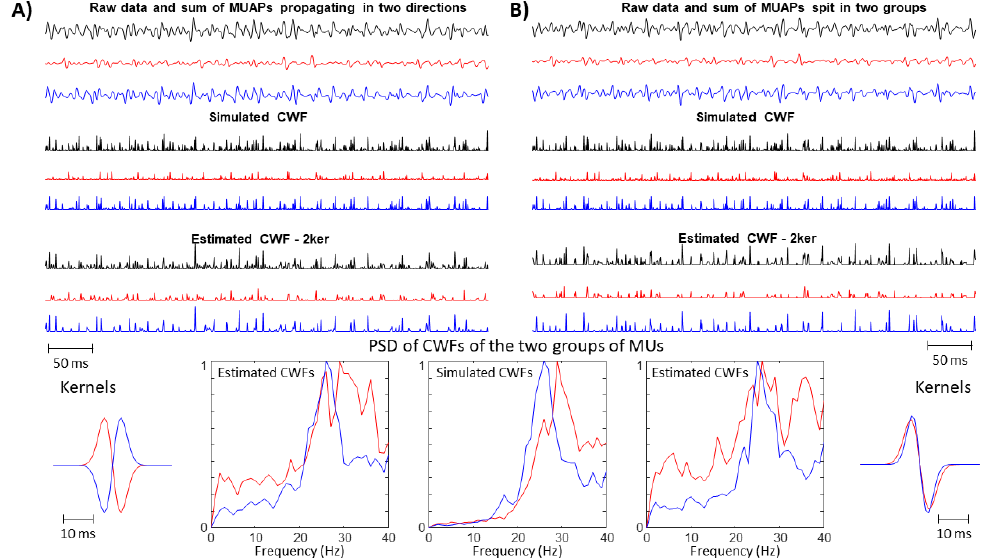
Figure 1. Example of simulated data (muscle with 100 MUs) and estimation of cumulative firings. ( A ) EMG from a muscle with two IZs (70% MVC, fat layer thickness of 3 mm, mean CV of 4 m/s, no synchronization between MU firings, CoV of ISI 10%, maximum FR 40 Hz), showing SD MUAPs with different phases. Small and large MUs are associated to different IZs (split into 75% of small MUs and 25% of large MUs, so that the amplitude of the two contributions is similar). The total signal and those corresponding to the activation of MUs innervated at different IZs are considered, showing (from up to down) a portion of EMG (0.5 s out of the simulated 10 s), the simulated CWF and the estimated CWF (considering two kernels, with opposite phase, with PSD fit to that of the data). Finally, the PSD of the simulated and estimated CWFs are shown. ( B ) The same as in ( A ) but considering a single IZ: in practice, the red signal is the same as in ( A ), whereas the blue one has the opposite phase. Two kernels are considered, with the same phase but different time scales (0.9 and 1.1 rescaling with respect to the kernel fit to the data). Abbreviations: cumulative weighted firings—CWF; firing rate—FR; innervation zone—IZ; maximal voluntary contraction—MVC; power spectral density—PSD; single differential—SD; motor unit (MU) action potential—MUAP; and coefficient of variation of interspike interval—CoV of